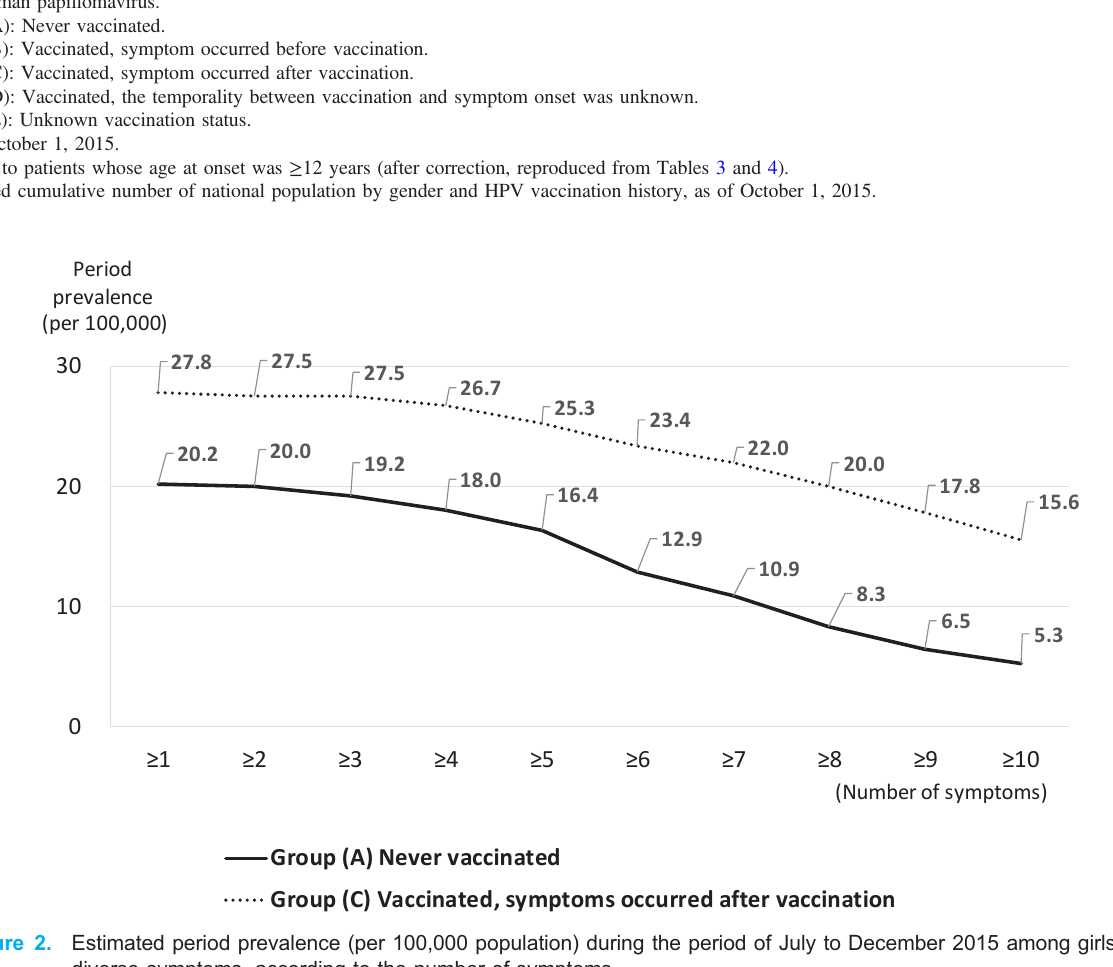
Figure 2. Estimated period prevalence (per 100,000 population) during the period of July to December 2015 among girls with diverse symptoms, according to the number of